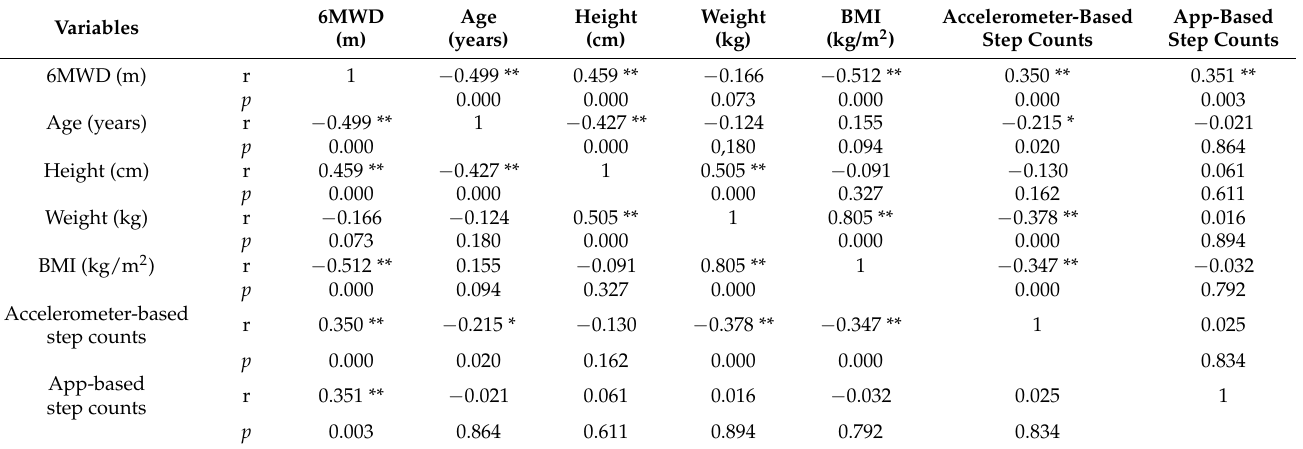
Table 3. Correlation matrix between the distance covered in the supervised 6MWT (6MWD), demo- graphic, anthropometric attributes and the total number of steps performed in the test ( n = 93).